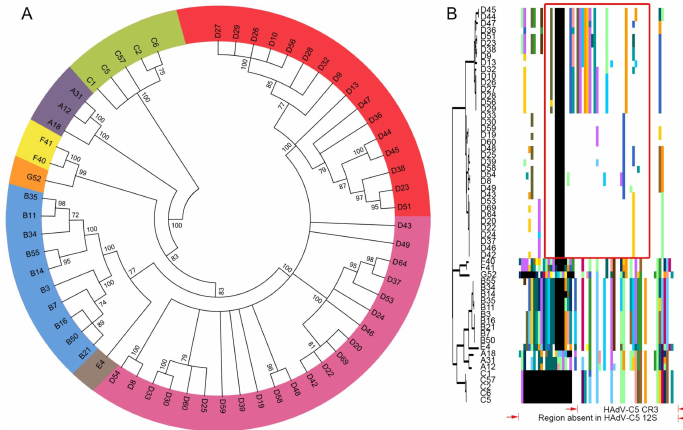
Figure 1. E1A 13S protein coding sequence analysis for human adenovirus (HAdV) species A–G reveals a unique evolutionary pattern for human adenoviruses of species D (HAdV-D). ( A ) Bootstrap-confirmed (500 replicates) neighbor-joining phylogenetic tree of E1A 13S protein sequence from 60 HAdVs including 38 HAdV-D. Bootstrap values below 70 were collapsed for the condensed tree. Each HAdV species is indicated by a unique color, except HAdV-D species which had two divergent subclades consisting of 16 (red) and 22 (purple) viruses. ( B ) Proteotyping analysis for the conserved region 3 (CR3) in E1A 13S protein for 60 HAdVs from seven HAdV species. Here, multi-sequence alignment is shown in respect to the maximum-likelihood tree with the consensus sequence hidden as a white background, while non-consensus colored regions represent unique shared protein signatures. The red box outlining the HAdV-Ds represents the most variable region within CR3 for the two HAdV-D groups, arbitrarily named group1 (upper proteotype encompassing HAdV-D45 to D29) and group2 (lower proteotype, encompassing HAdV-D33 to D42), each with highly distinct amino acid signatures. The CR3 of HAdV-Cs, as exemplified by the well-studied HAdV-C5 (red arrows), is the smallest in length among all HAdV